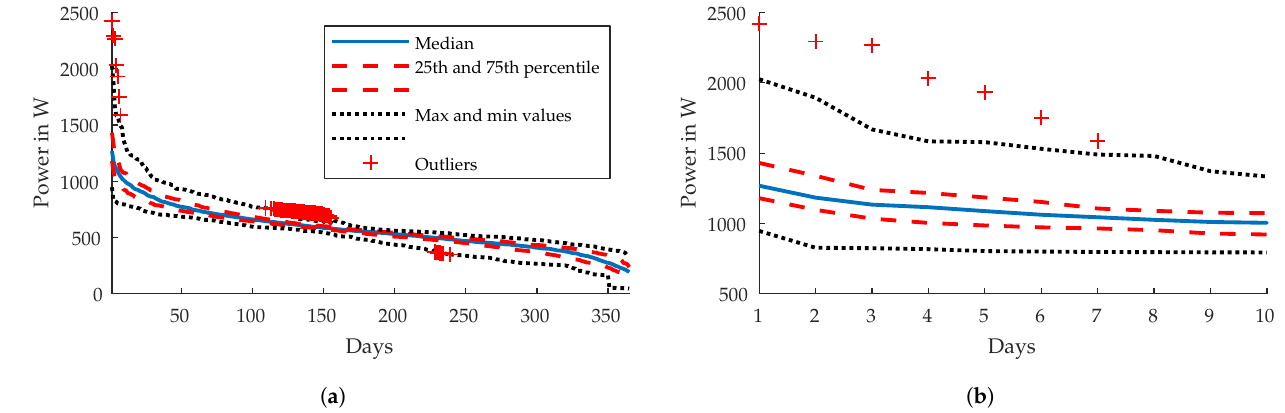
Figure 8. ( a ) Load duration curve based on daily averages. ( b ) Zoomed version of ( a ). The load data stem from regular grid-connected households, in which no incentives for avoiding rare but extreme load peaks exist. However, in an off-grid home, it can be expected that occupants are more aware of power limitations, as the costs of sizing components for a worst-case scenario is disproportionate. Hence, a load duration curve based on 10-min averages was prepared and the data scanned for households with extreme load peaks (compare Figure 9). The 10 10-min intervals with highest average load were taken as the basis for excluding outliers (compare Figure 9b). That way, three outliers (households 4, 5, 6) were identified for exclusion. All in all, this leaves a database of 65 households, which can be reasonably compared with a standard hardware